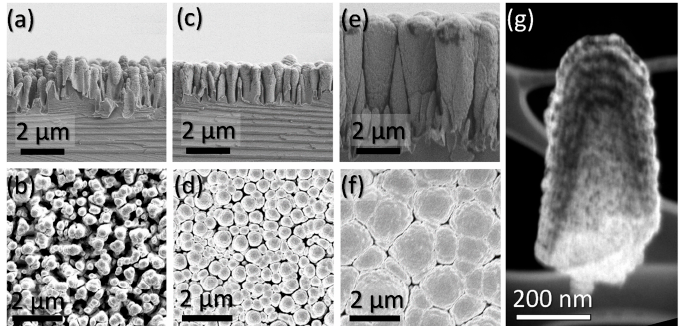
Figure 1. SEM micrographs of multilayers with different thickness, grown on black silicon nanostructures: ( a , c , e ) cross section of multilayers with 500 nm, 1 µm, and 5 µm thickness; ( b , d , f ) top view on the respective layer; ( g ) dark field TEM image of a nanostructure tip with 20 nm radius, coated with a 250-nm-thick multilayer.